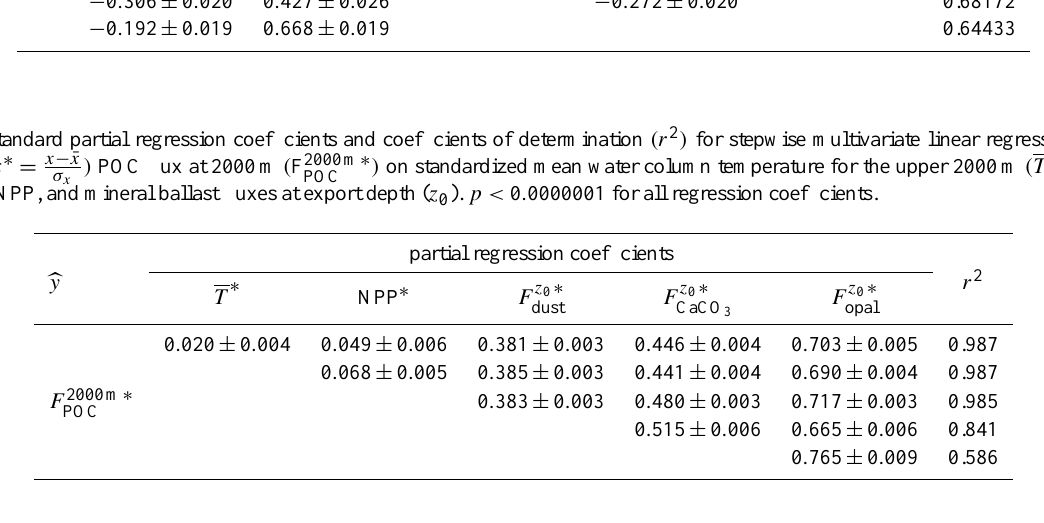
Table 4. Standard partial regression coefficients and coefficients of determination (r 2 ) for stepwise multivariate linear regression of